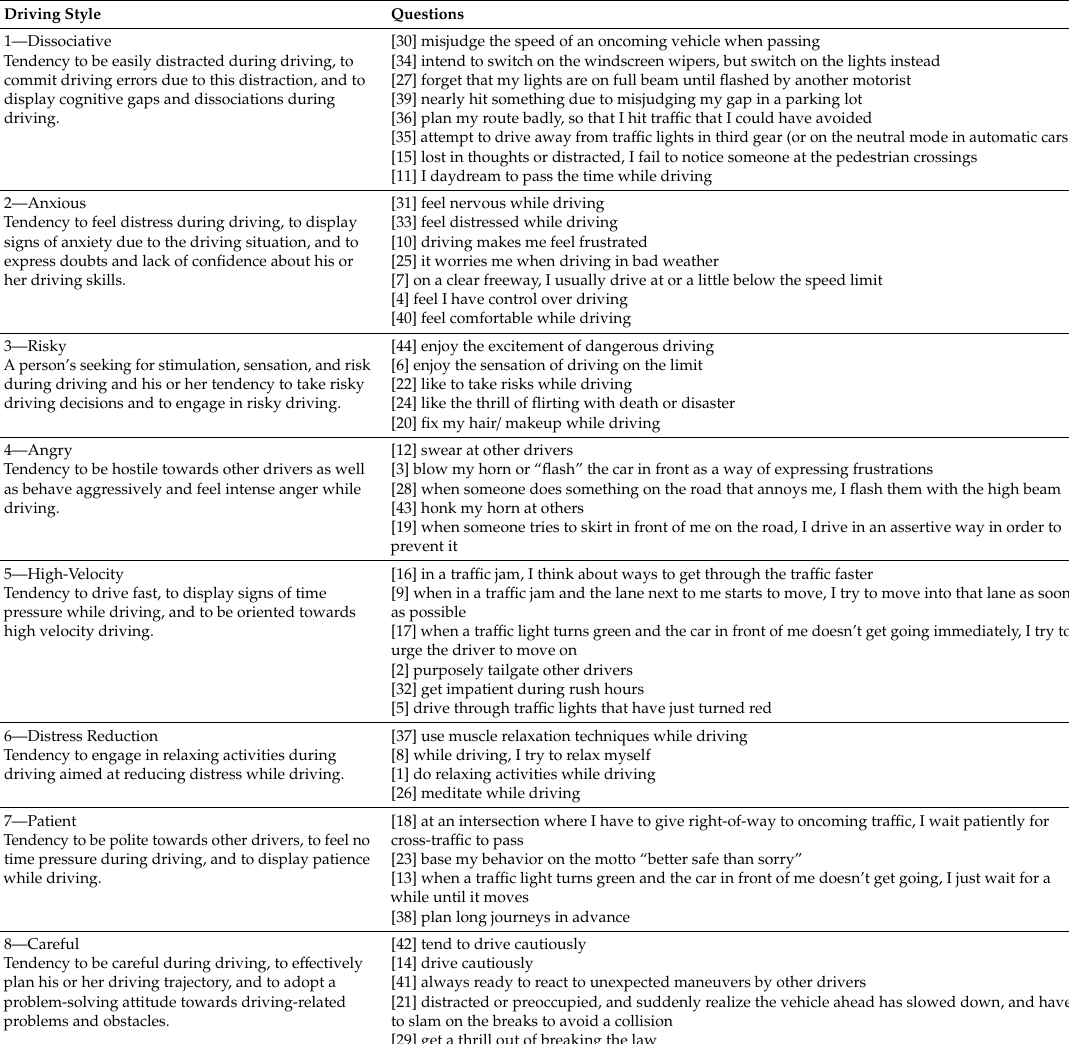
Table 2. Self-assessment questions* and mapping to driving style factors from Taubman-Ben-Ari et al. (2004). (*) The number in [] indicates the order in which the question is